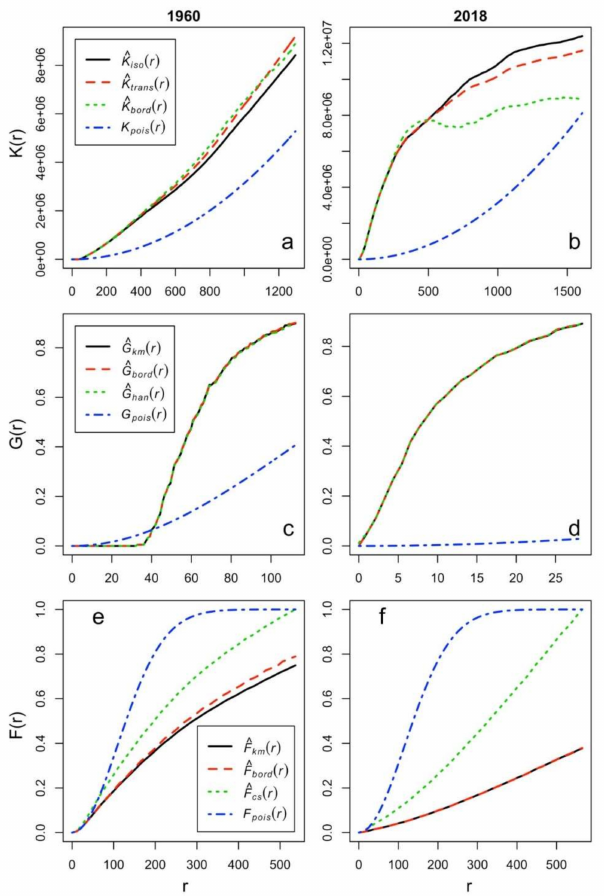
Figure A1. Results of point pattern analysis for RWA nests mapped in 1960 (left) and 2018 (right). (K = Ripley’s K function ( a , b ); G= the nearest-neighbor function ( c , d ); F = the empty-space function ( e , f ); „pois” = random, theoretical distribution Poisson; „bord” = border correction; „iso” = isotropic correction; „trans” = translation correction; „km” = Kaplan-Meier correction; „han” = Hanisch correction; „cs” = Chiu-Stoyan correction). The pattern shows clustering as [44]: -the curve for the empirical K-function is clearly above the theoretical curve (valid for a completely random pattern), showing that a nest has more neighbors than expected (when the pattern would be completely random);-for the G-function (which is interpreted in a similar manner to the K-function), the curve for the empirical data is above the theoretical curve (valid for a completely random pattern) and shows that the nearest-neighbor distances are shorter than expected under a random pattern;-for the F-function, the interpretation is opposite. The empirical curve is below the theoretical one meaning that empty-space distances are larger than expected in a random